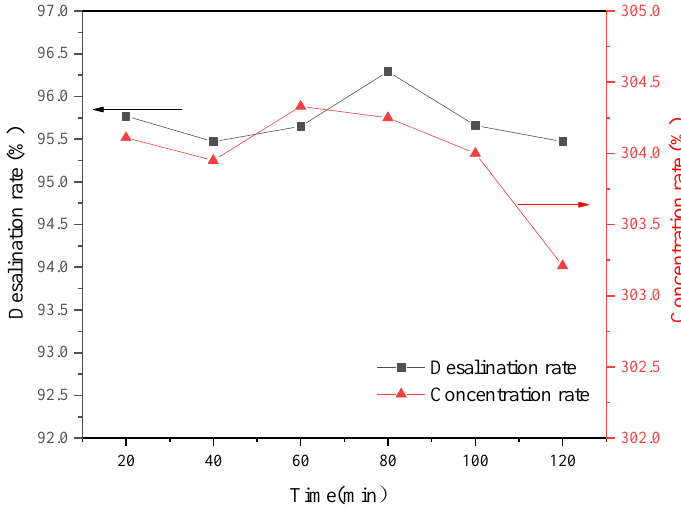
Figure 9. Effect of time on the desalination and concentration rates.